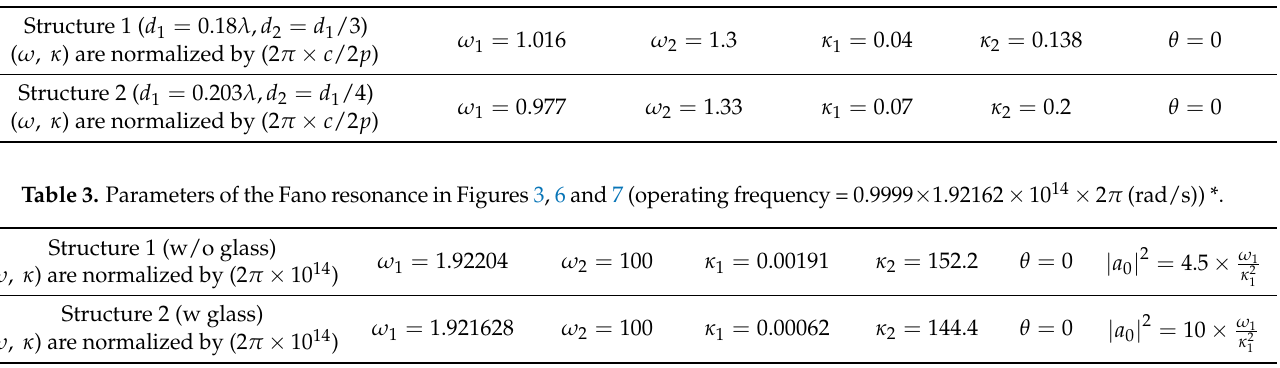
Table 2. Parameters of the Fano resonance in Figure 4.